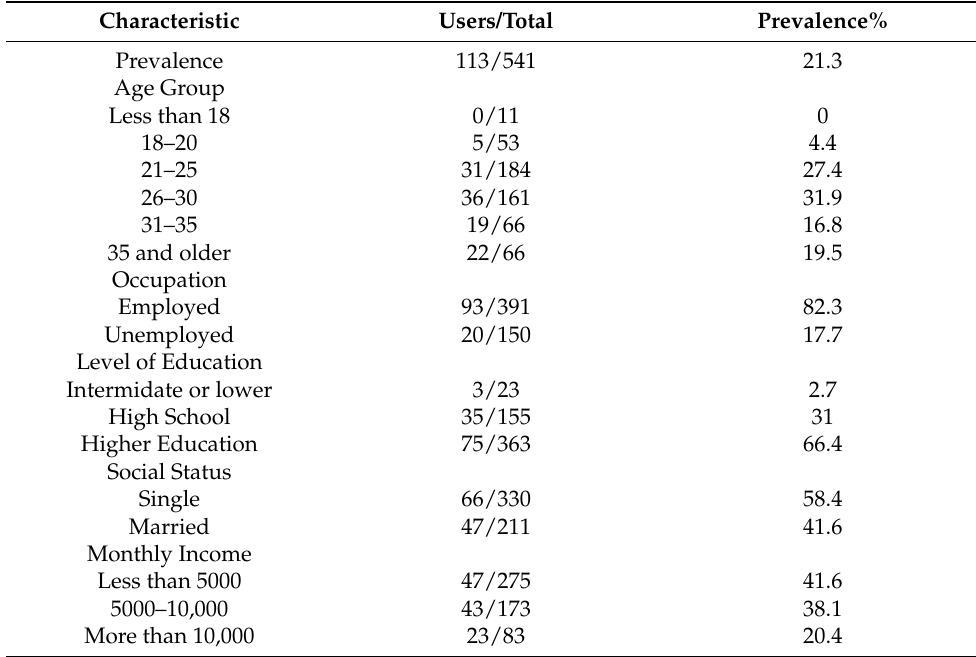
Table 3. The prevalence of anabolic steroid use according to selected characteristics.